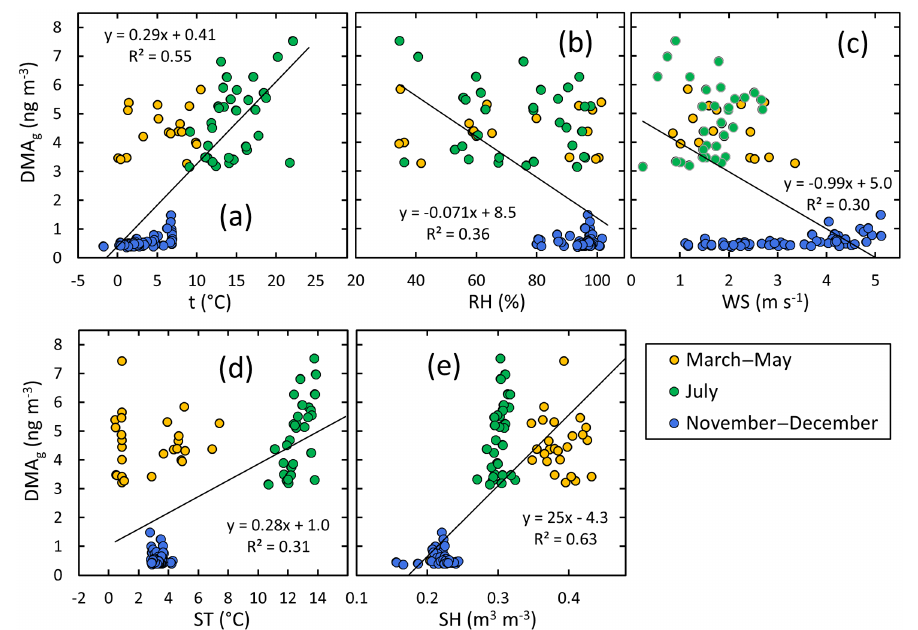
Figure 6. DMA in the gas phase vs. selected ambient condition parameters: (a) air temperature, (b) relative humidity, (c) wind speed, (d) soil temperature, and (e) soil humidity in spring, summer, and early winter. The linear regressions shown in the plots were calculated using the data points of all seasons.